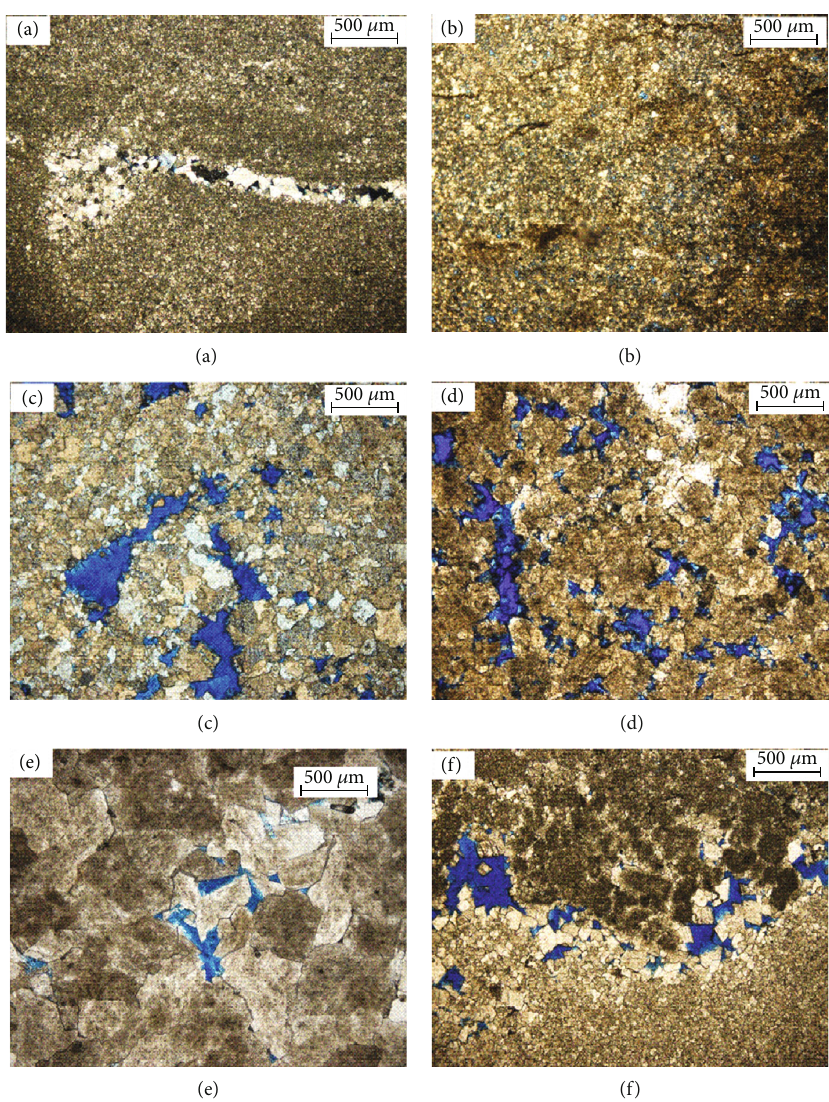
Figure 2: The thin section images of di ff erent types of dolomite. (a) Thin section image of MD sample S18 with low porosity value 1.38%. It shows that the intergranular pores are not developed and the fractures are fi lled with quartz, asphalt, and other minerals. (b) Image of SD sample S32 with porosity 5.07%. The pore space consists of medium and small intergranular pores and dissolved pores. (c) Image of FD sample S5 with porosity 14.87%. The pores are mainly larger intergranular dissolved pores. (d) Image for MD sample S4 with porosity 10.2%. Intergranular pores and intergranular dissolved pores with large size mainly develop in such type of dolomite. (e) Image of CD sample S22 with porosity 2.21%. The intergranular pores were slightly developed. (f) Image of GD sample S19 with porosity 4.43%. Dolarenite was recrystallized as fi ne crystalline dolomite. The intergranular dissolved pore with medium scale distributes along